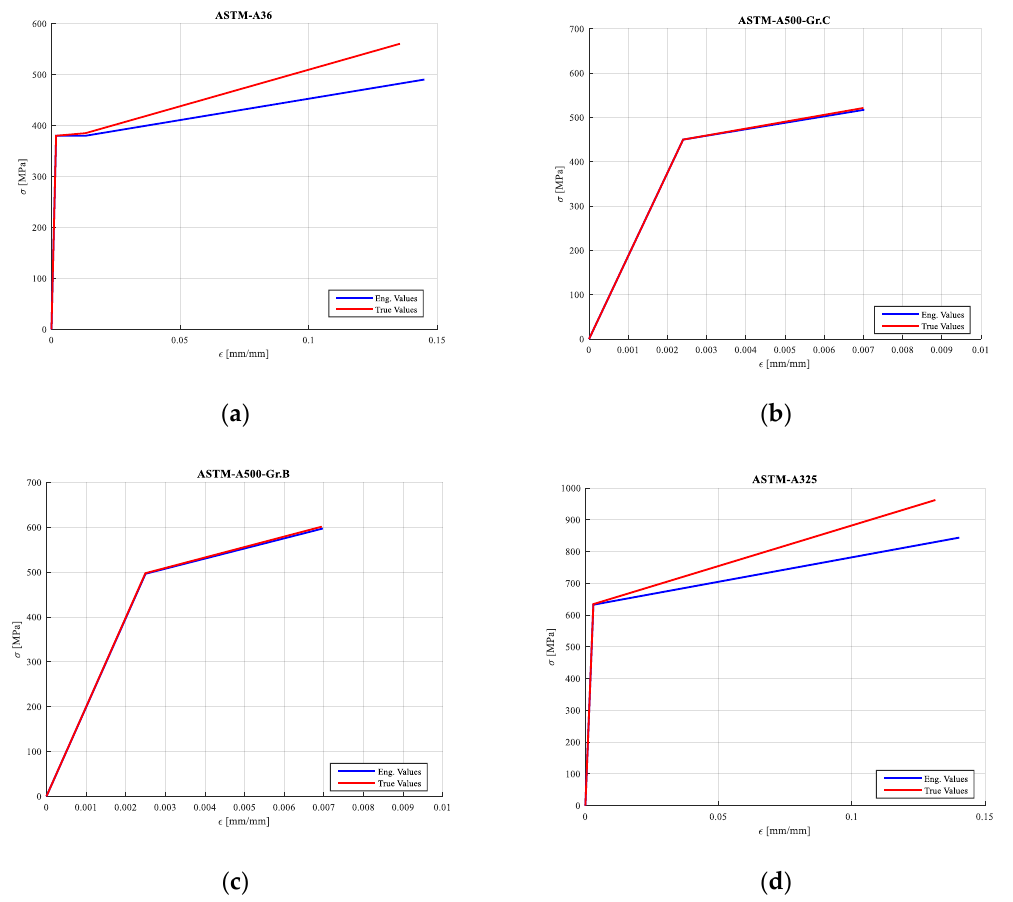
Figure 12. Relation stress-strain of materials used in experimental and numerical study: ( a ) ASTM-A-36 material (stiffeners and end-plates), ( b ) ASTM-A-500 Gr. C material (beam), ( c ) ASTM-A-500 Gr. B material (column) and ( d ) ASTM-A-325 material (bolts).